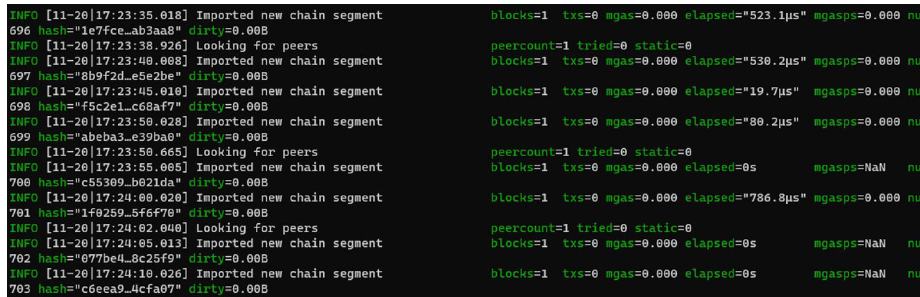
Figure 8. Validating node with 5 s block period.